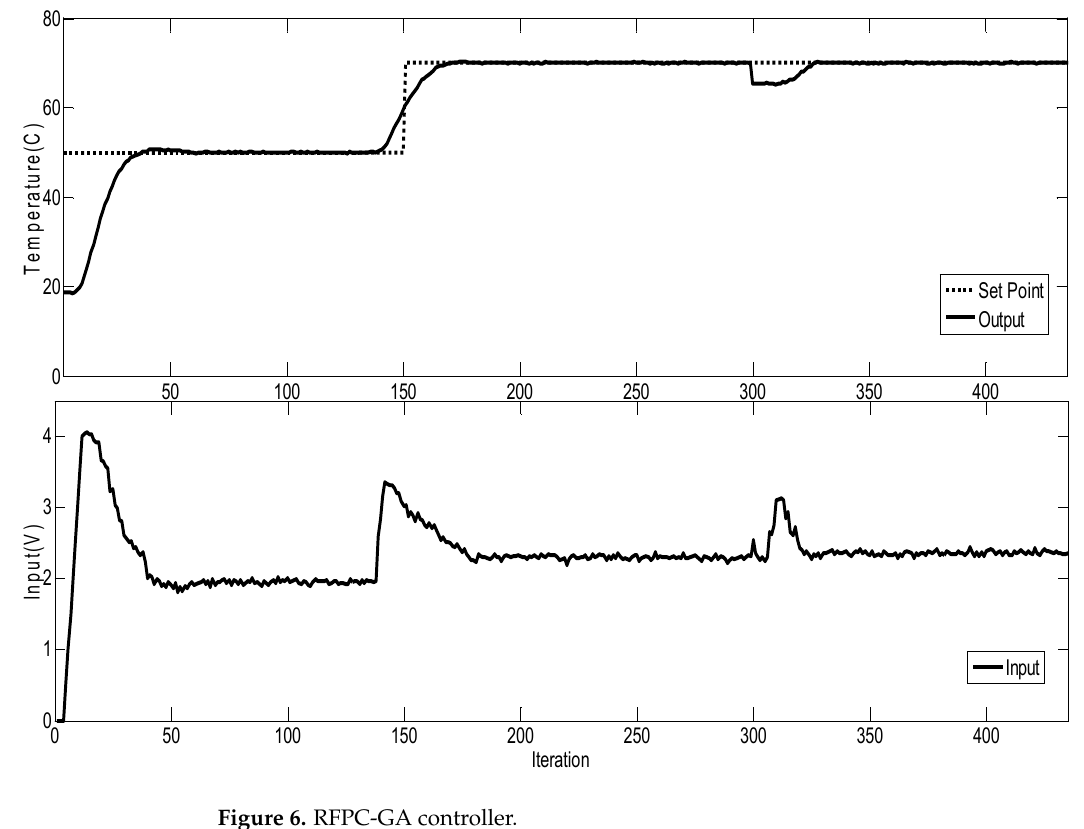
Figure 6. RFPC-GA controller.